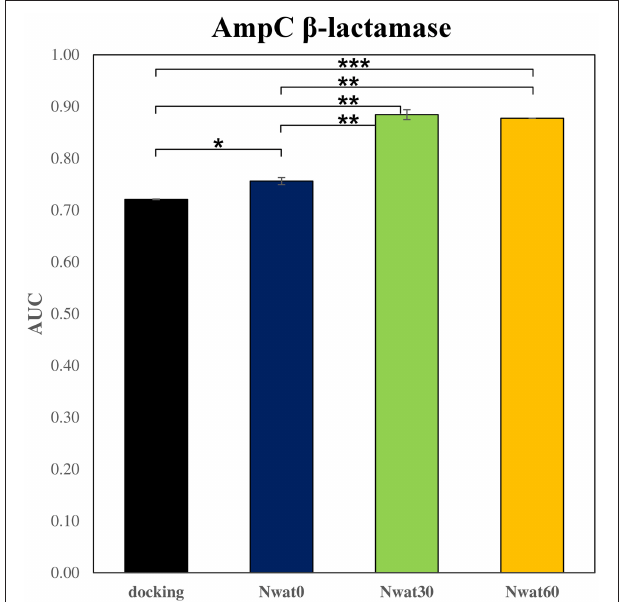
FIGURE 5 | Average ROC AUC values for AmpC β -lactamase. Statistical significance was calculated by t -test and is graphically reported only when a significant variation was observed (* P < 0.05; ** P < 0.01; *** P < 0.001).